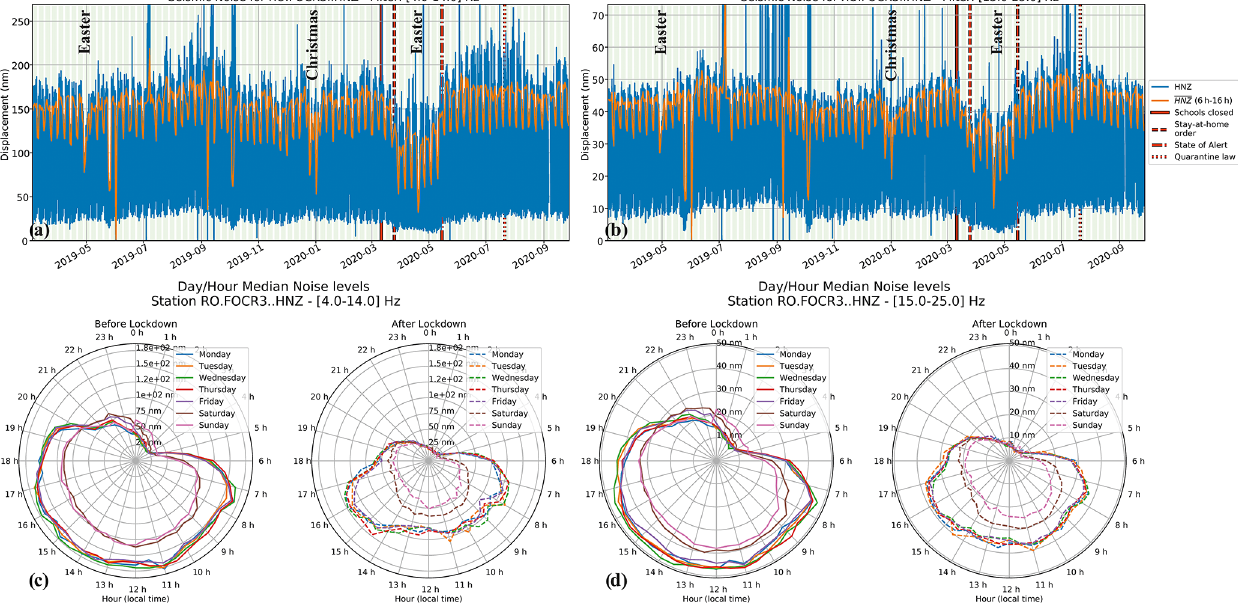
Figure 11. Temporal changes in seismic noise observed at the station located on the eighth floor of the Unirea Hotel in Focsani in the frequency bands 4–14Hz (a) and 15–25Hz (b) . Lockdown effects are shown on 24h clock plots in the frequency bands 4–14Hz (c) and 15–25Hz ( d ) (see Fig. 1 for the station